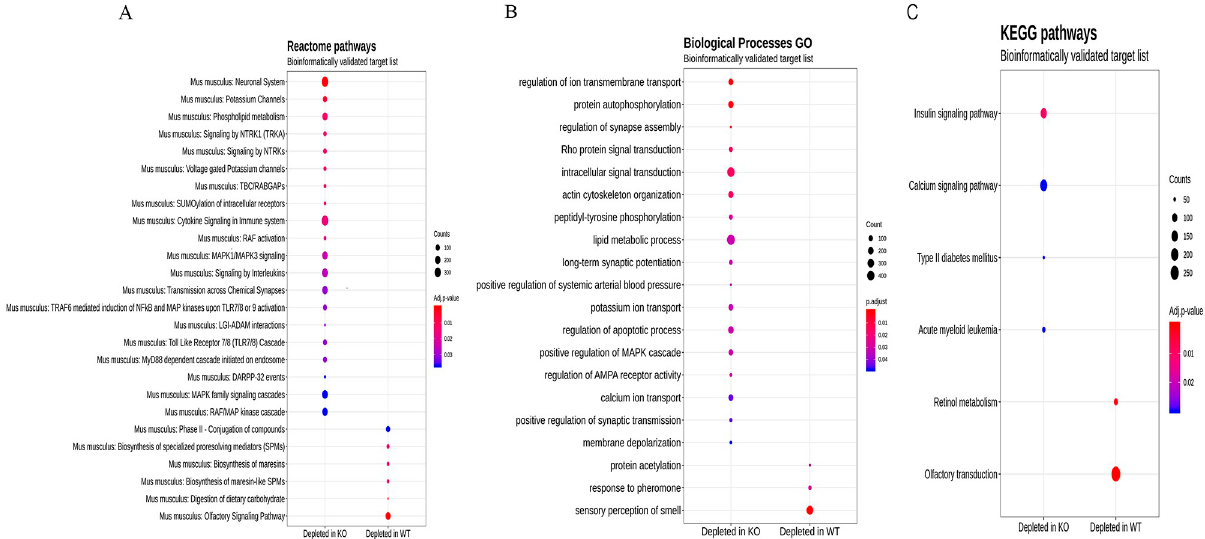
Fig 5. Enrichment analyses: Enrichment analyses results using miRNA to target the bioinformatics and experimental lists from the miR Database and TargetScan. Analyses were performed with mdgsa [31] and clusterProfiler [32]. ( A ) Reactome pathways. ( B ) Biological Processes GO. ( C ) KEGG pathways. Abscissa axis indicates if the pathway or function is depleted in the WT or the knockout group. Ordinate axis displays the GO term or the pathway. The size of the round node is the number of genes in the function. Color is the adjusted p-value. Raw p-values were adjusted by FDR (Adjusted p-value <